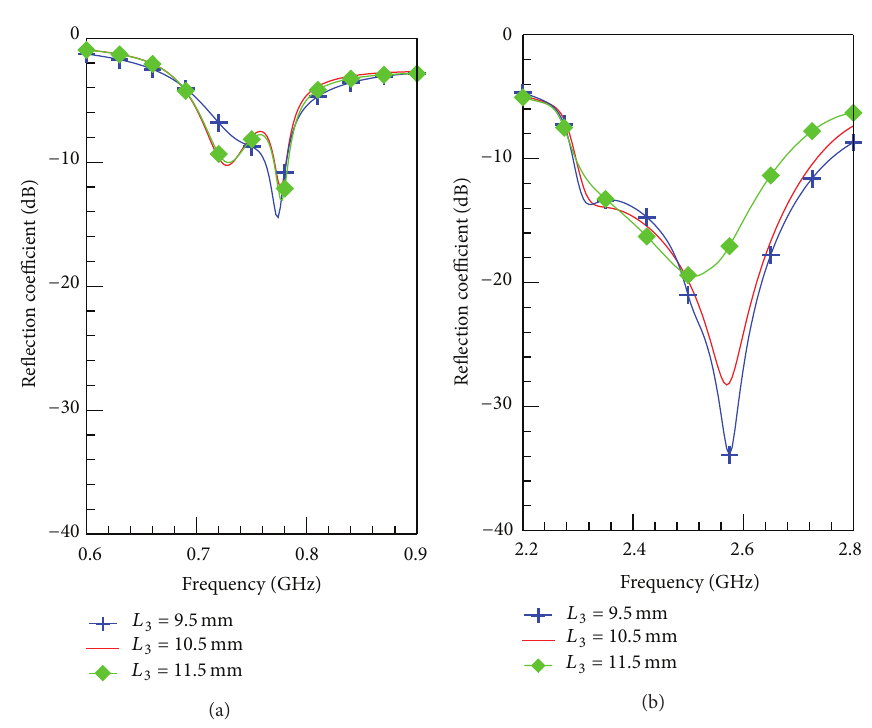
Figure 8: Simulated reflection coefficient of the proposed antenna as the function of 𝐿 3